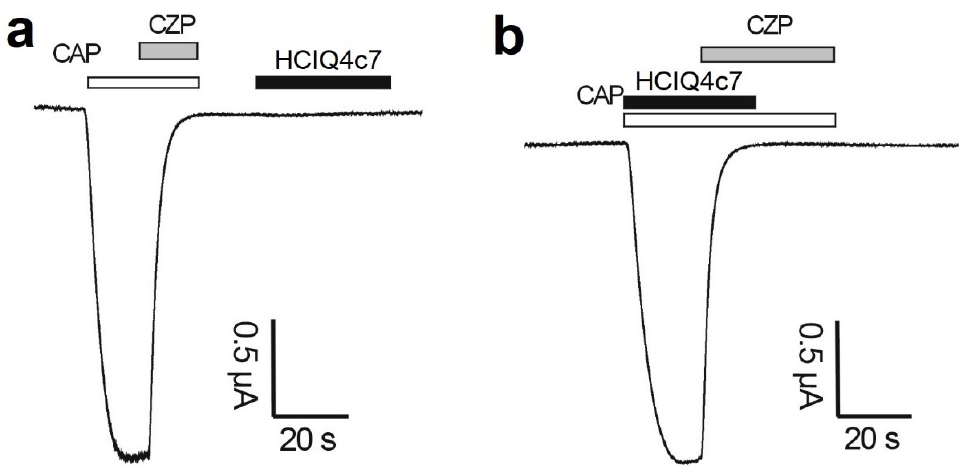
Figure 10. Effect of HCIQ4c7 on TRPV1 channels expressed in X. laevis oocytes. Whole-cell current traces of capsaicin (CAP = 2 µM) and capsazepine (CZP = 10 µM). Applications of HCIQ4c7 alone ( a ) or in the presence of capsaicin ( b ) are shown. The image was taken using pClamp Clampfit 10.0 (Molecular Devices, Downingtown, PA, USA) and Origin 7.5 software (Originlab, Northampton, MA, USA).